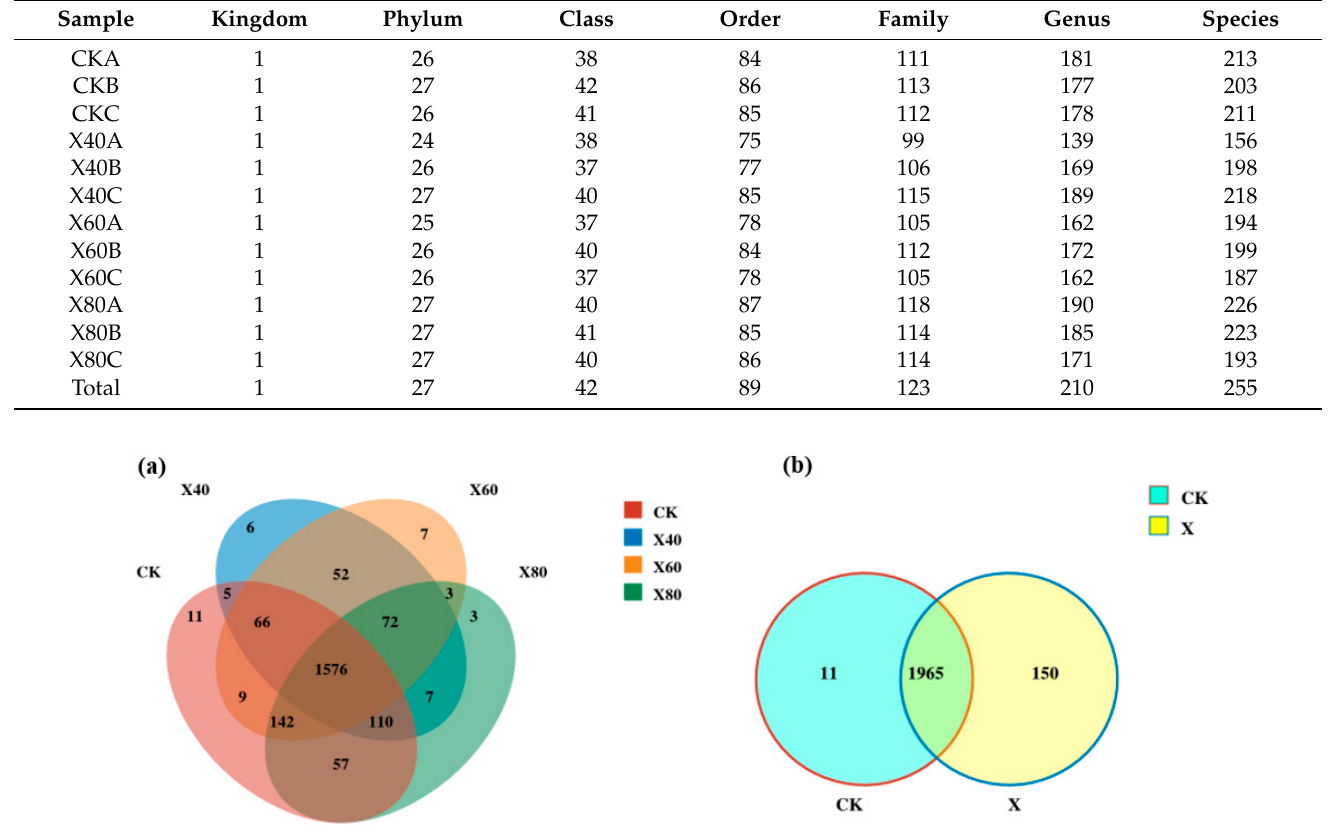
Table 5. Statistics of bacterial species at each rank in the rhizosphere soil samples of L. barbarum under different root restriction treatments.